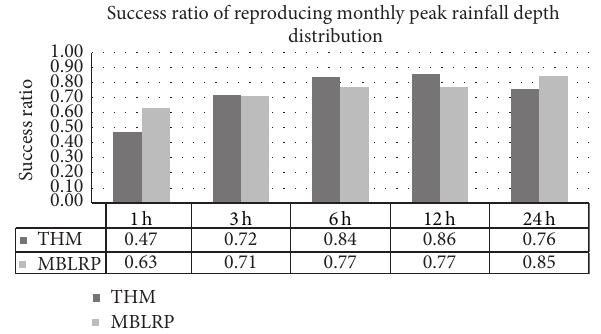
Figure 10: The proportions among 104 gauges that THM and the traditional approach succeeded in reproducing the distribution of the observed monthly maximum rainfall depths with 1, 3, 6, 12, and 24 hours of